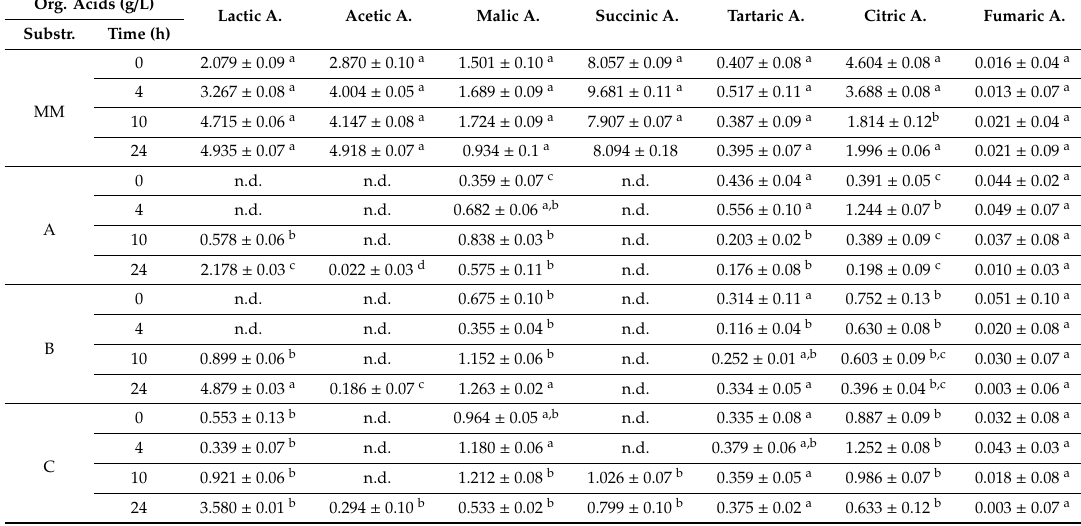
Table 4. Organic acid production through fermentation with Lp + Lc +